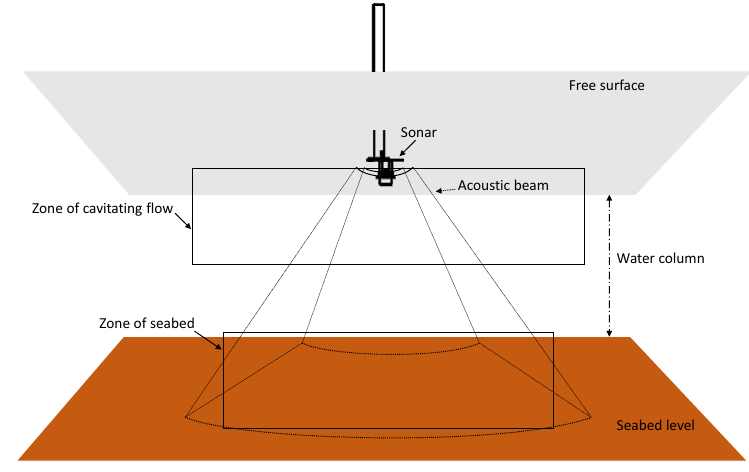
Figure 4. Scheme of how to interpret a multibeam acoustic image that contains cavitating flow.